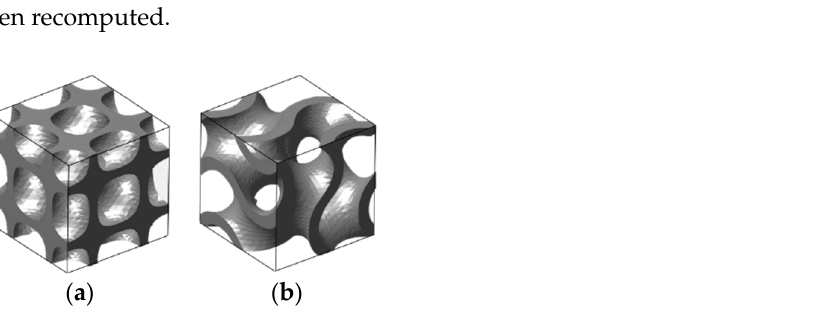
the optimal results in this study. optimal results in this